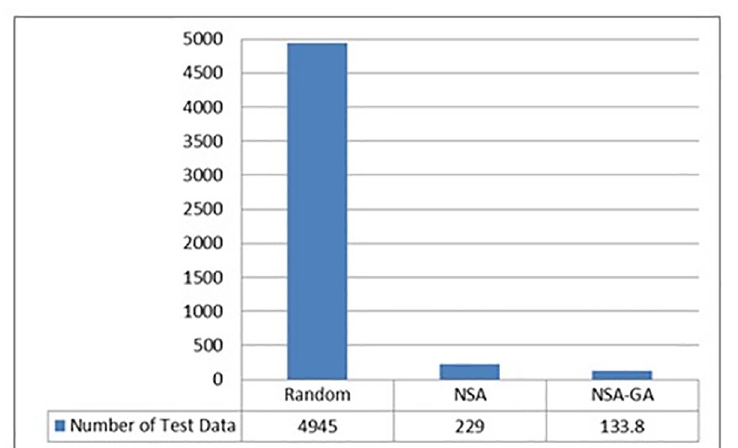
Fig 7. Average amount of test data to fulfill all TriTyp program